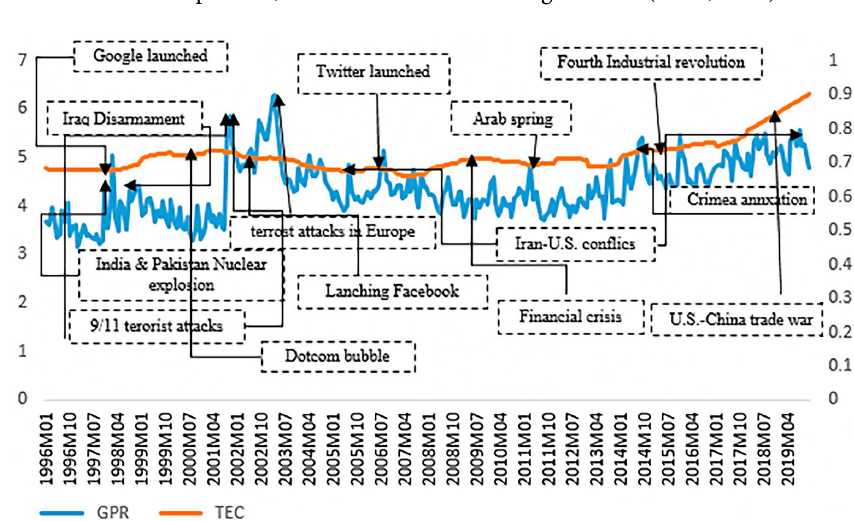
Figure 1. Trends of GPR and